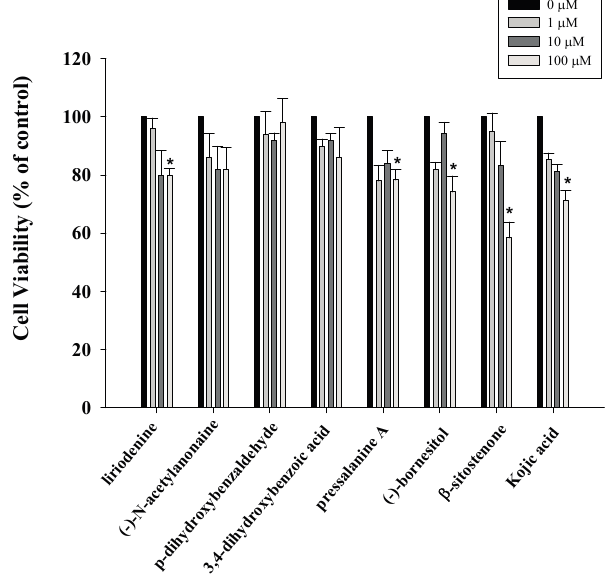
Figure 2. Anti-proliferative effects of compounds on B16F10 cells. Cell growth was determined by XTT assay after incubation with 1, 10, 100 μ M of different compounds. Results are expressed as the percent of the cell proliferation of the vehicle control at 24 h. Values are expressed as means ± S.D. of n = 3. * p < 0.05 vs. vehicle control